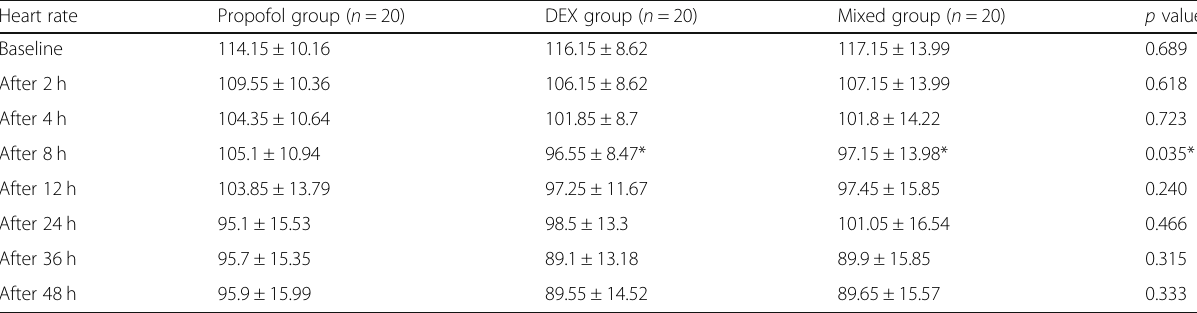
Table 3 Heart rate changes in the studied groups